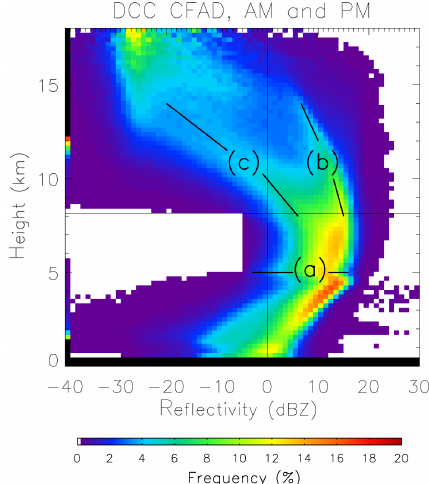
Figure 3. The contoured frequency by altitude diagrams (CFADs) of reflectivity for DCCs in Amazonia. The colors represent the prob- ability density function (PDF, as percentage) of radar reflectivity at each 240m tall layer observed by CloudSat. The vertical (hori- zontal) black line indicates 0dBZ (8km). Three distinct features of the CFAD, discussed in the text, are labeled on the figure. (a) indi- cates the dark band, with the horizontal line segments showing the mean altitude. (b) and (c) mark the locations of the high and low reflectivity arcs, respectively. The diagonal line segments show the orientation of each arc, and the rough values of the PDF